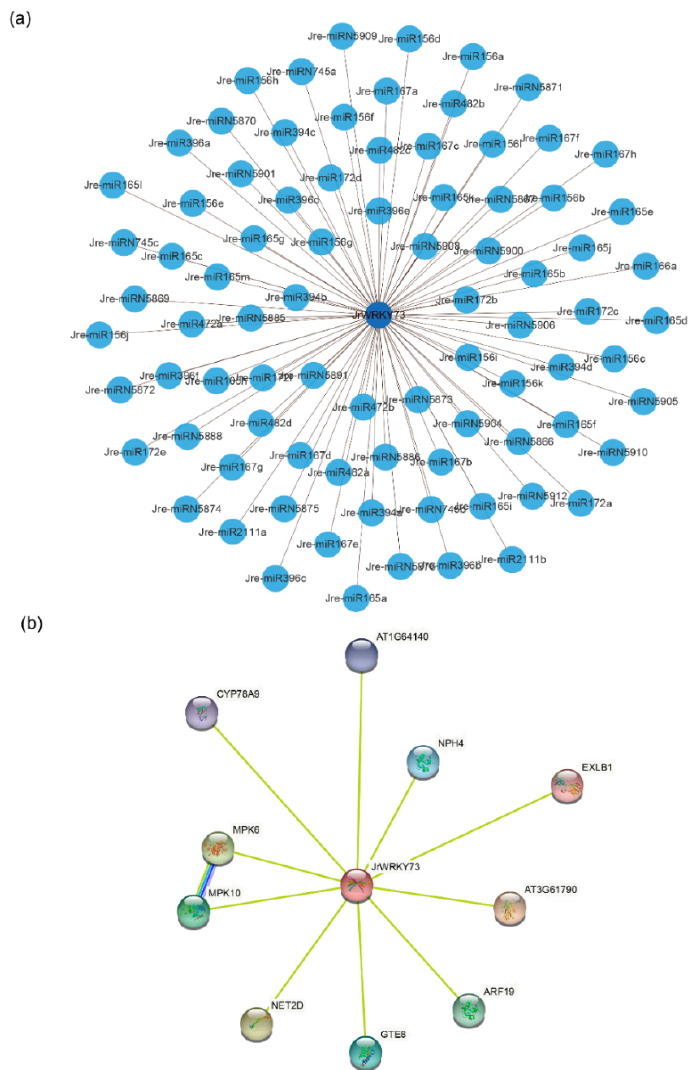
Figure 9. ( a ) A schematic representation of the regulatory network relationships between the putative miRNAs and their targeted walnut WRKY genes. ( b ) JrWRKYs interaction network. JrWRKYs interaction network was constructed using Arabidopsis homologous WRKYs . Proteins are represented by network nodes. The 3D protein structure is displayed inside the nodes. Edges represent associations of proteins.